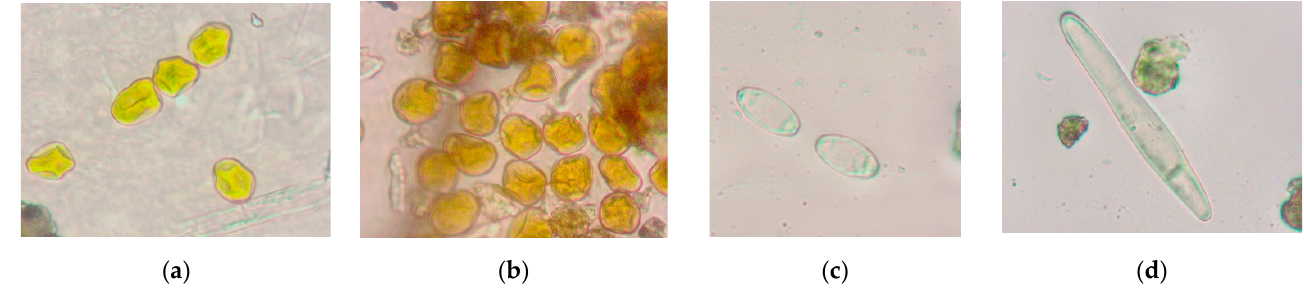
Figure 2. Spores of pathogens found in crops: ( a ) P. striiformis ; ( b ) P. triticina ; ( c ) E. graminis ; ( d ) P. tritici-repentis .